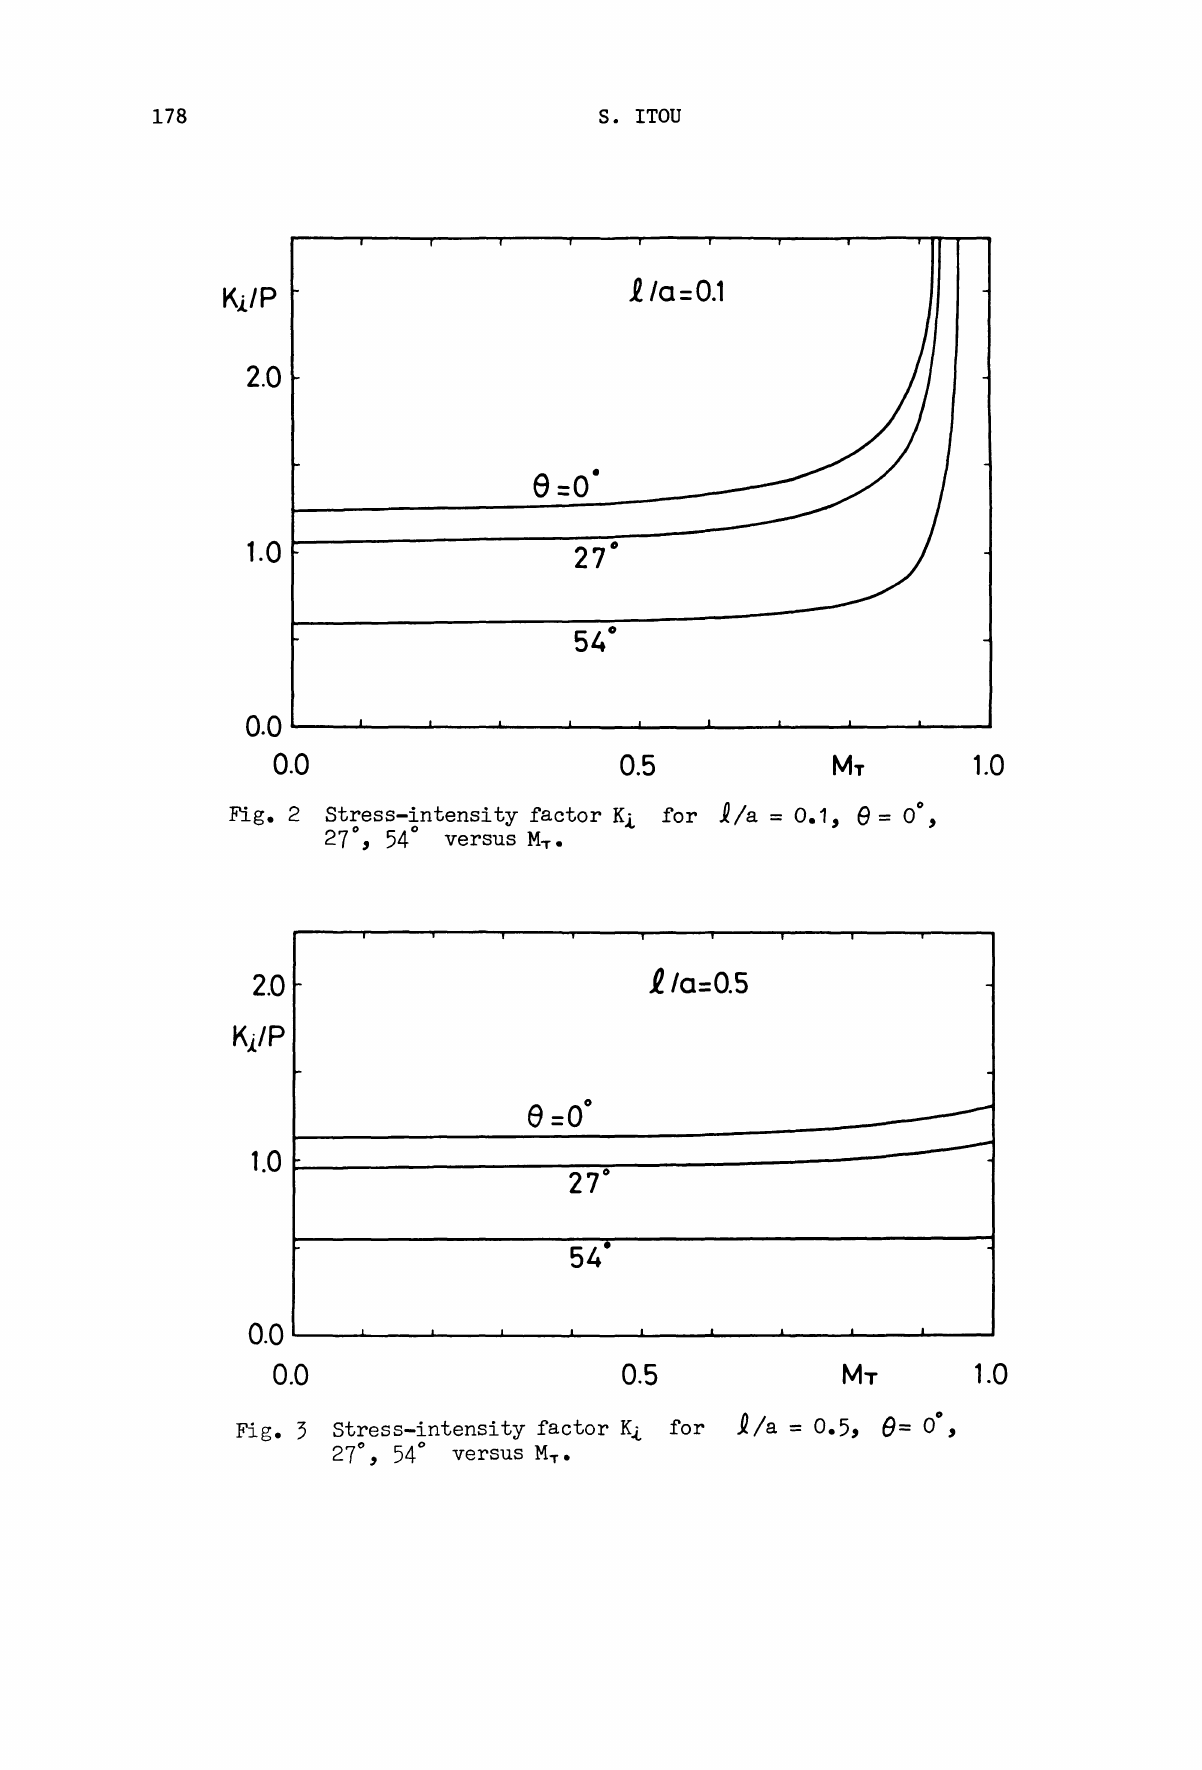
, Fig 5 Stress-intensity factor Ki for 54" versus 27